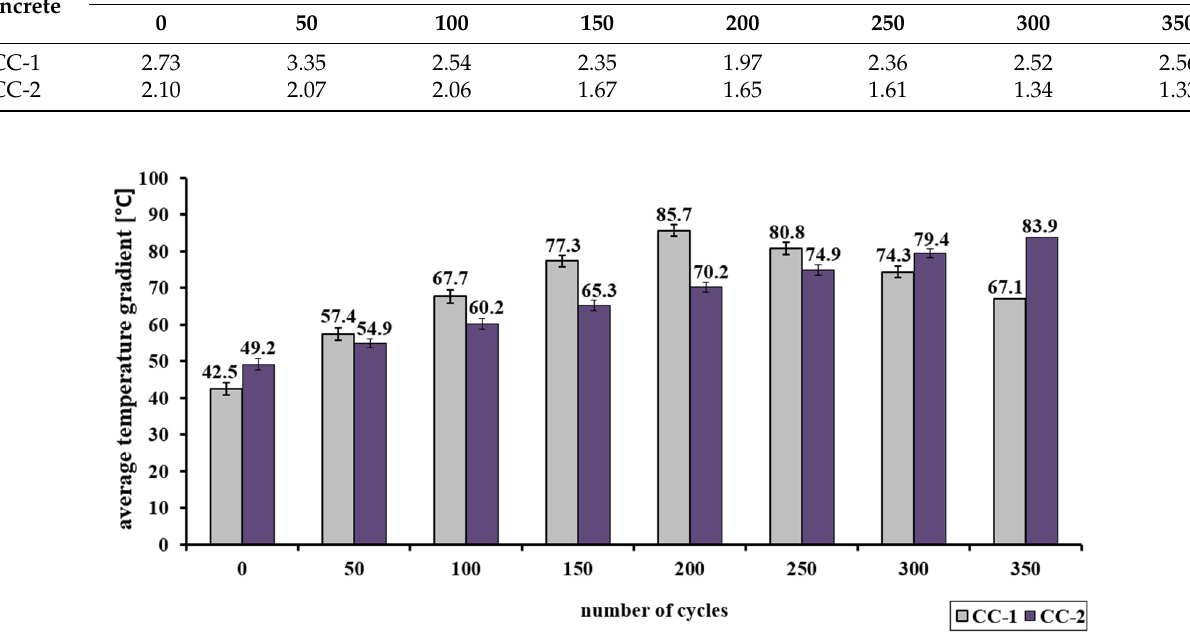
Figure 19. Change of the average compressive strength of CC-1 and CC-2 concrete as a function of the number of cycles—scheme A.